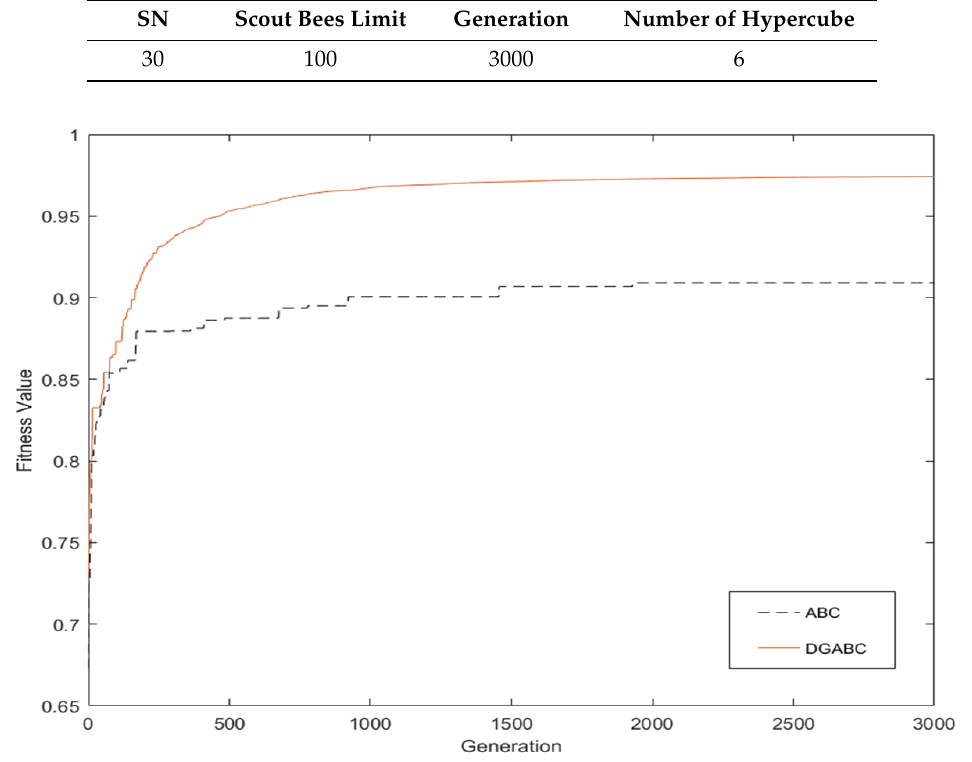
Table 1. The parameters of Interval Type-2 RFCMAC Model.